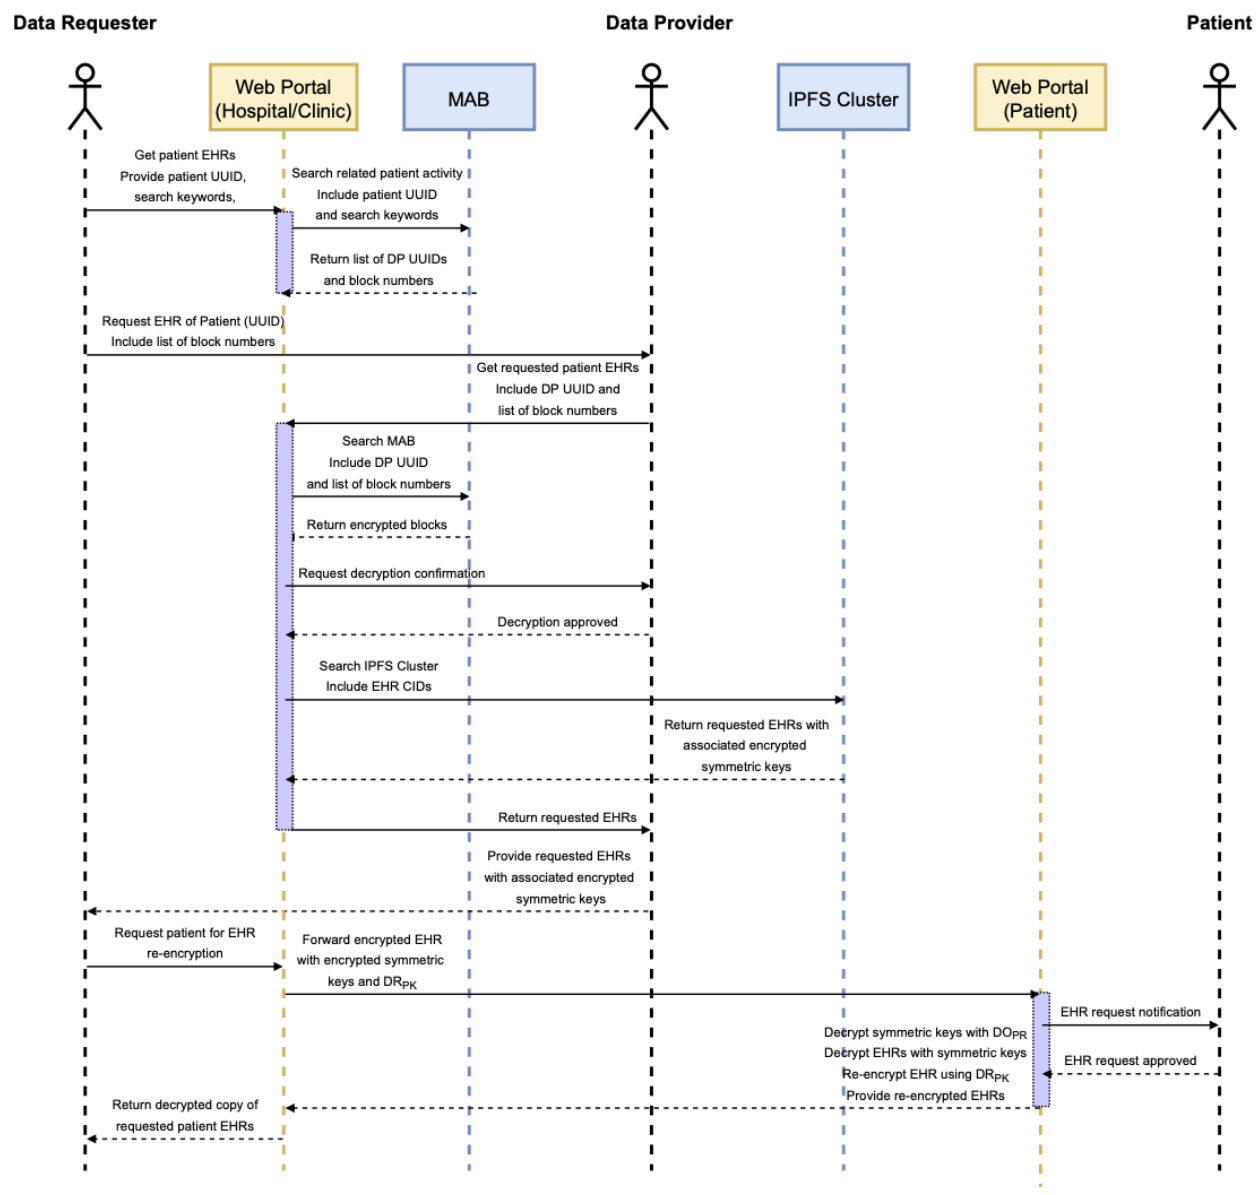
Figure 15. EHR request fulfillment sequence diagram.